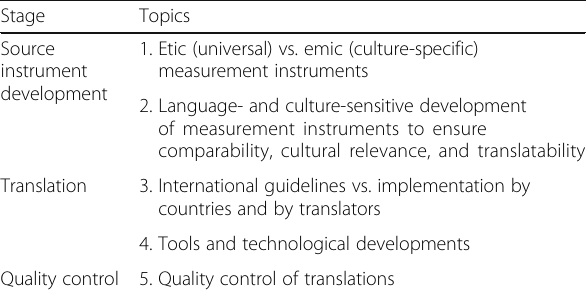
Table 1 Overview of topics covered at the seminar